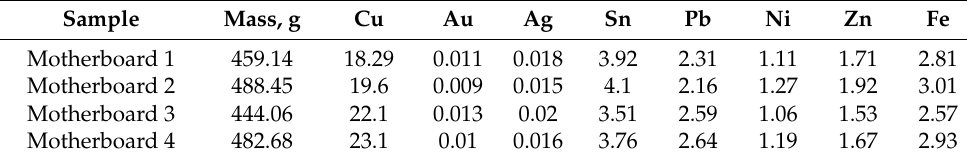
Table 2. Concentration (wt.%) of the most important metals in the WPCBs